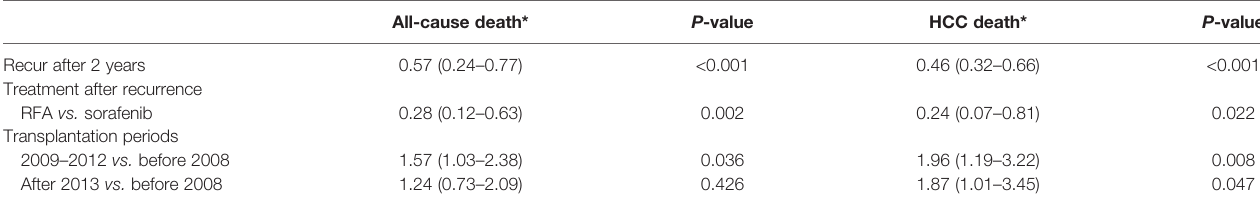
TABLE 4 | Prognostic factors for all-cause and HCC mortality after post-transplant recurrence in multivariable analyses.